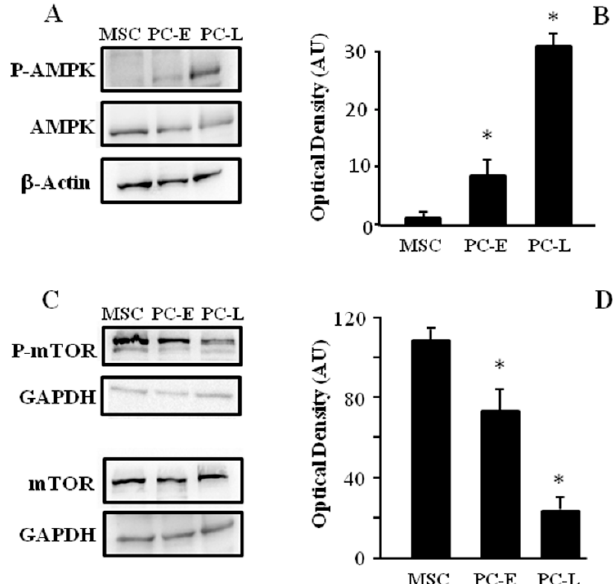
Figure 4. AMPK and mTOR phosphorylation levels change with melanoma cell differentiation. MSC, PC-E and PC-L were lysed and protein samples were subjected to Western blot using β -Actin or GAPDH as a loading control. Representative panels of P-AMPK and AMPK ( A ); and P-mTOR and m-TOR ( C ) are shown; ( B , D ) densitometric analyses of P-AMPK/AMPK and P-mTOR relative to the corresponding loading control, respectively, reveal progressive P-AMPK/AMPK increase and progressive P-mTOR decrease as function of time of differentiation. Data are presented as the mean ± s.d. expressed as AU of three independent experiments. * indicates p ≤ 0.05 in PC vs . MSC.